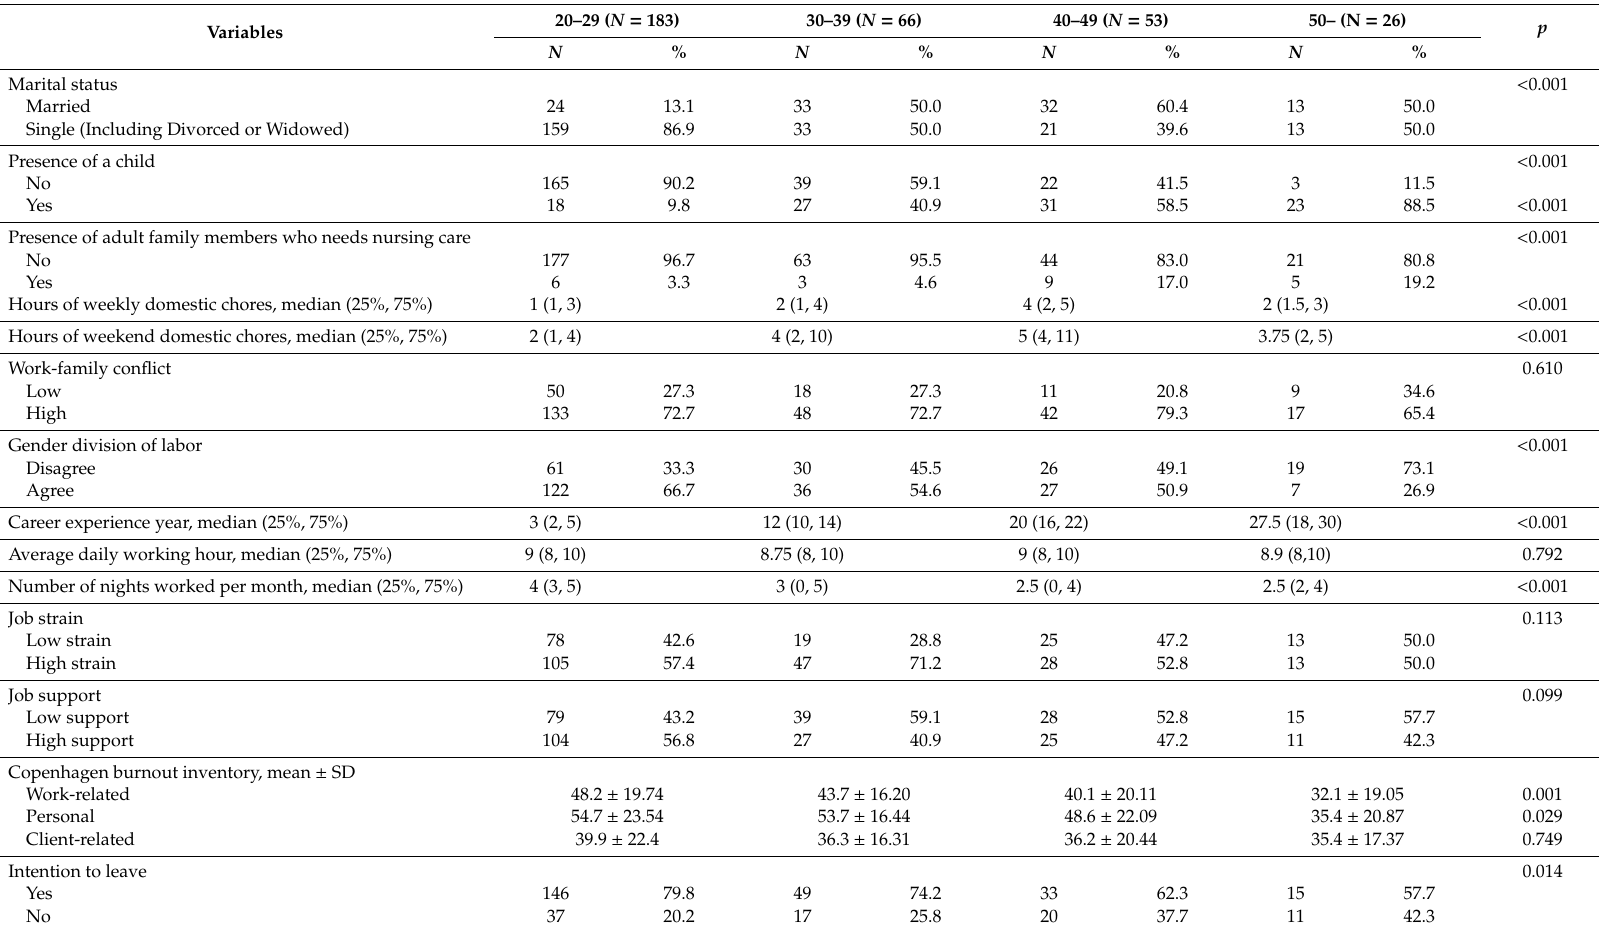
Table 1. Characteristics according to age group ( N =